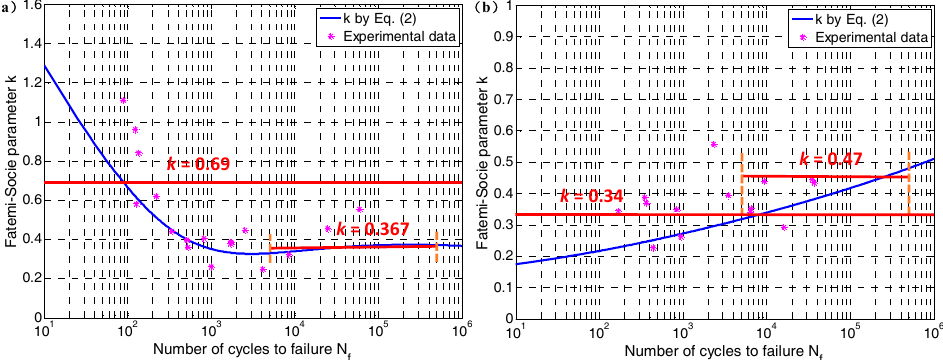
Figure 1. Fatemi–Socie parameter k for ( a ) TC4 and ( b ) GH4169. Materials 2017 , 10 , 924